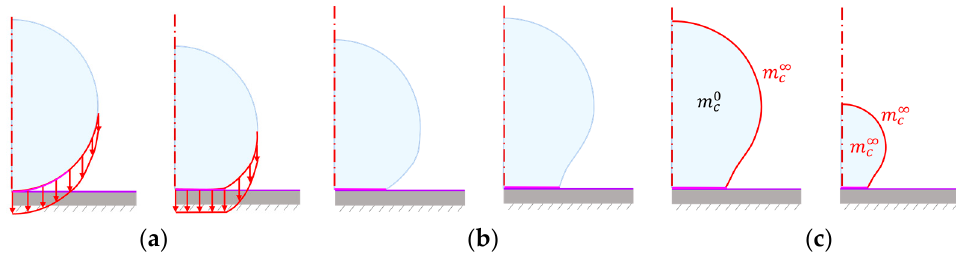
Figure 2. The three steps of the stress-shrinkage analysis with illustrated boundary conditions: ( a ) compaction, ( b ) unloading, and ( c ) shrinkage. ( a ) compaction, ( b ) unloading, and ( c )